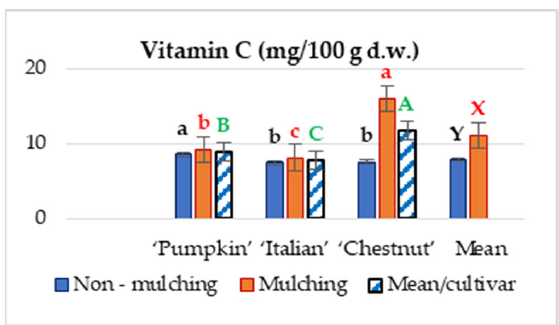
Figure 5. Vitamin C in tuberous sweet potato roots (mg/100 g d.w.) Bars represent standard error. Means followed by same letter are not significantly different (Tukey’s multiple range test, p < 0.05).